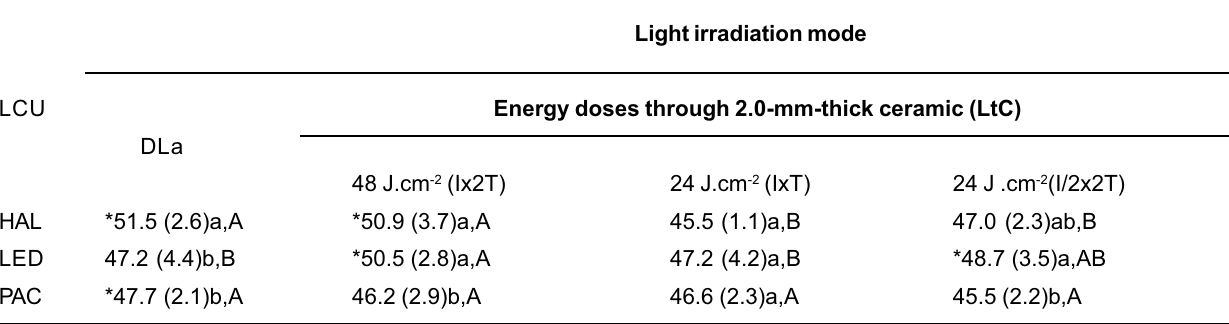
LCU= light-curing unit; HAL= tungsten halogen light; LED= light-emitting diode and PAC= xenon plasma-arc; DLa= direct light-activation; Different uppercase letters in rows represent statistically significant differences (p<0.05) among light irradiation modes for each LCU. Different lowercase letters in columns represent statistically significant differences (p<0.05) among the LCUs for each light activation mode. Standard deviations are given in parenthesis for each mean. (*) means are significantly higher than control (chemical activation only) [44.7 (3.8)].